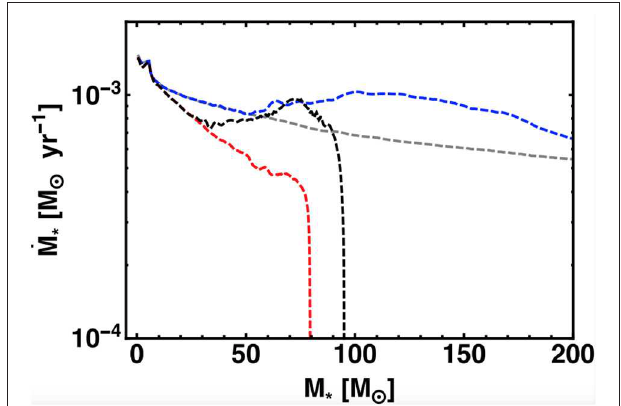
FIGURE 12 | The role of radiation and protostellar jet feedback in the formation of massive stars. Gray line is for outflow feedback only; blue line, outflow + photoionization feedback; red line, ouflow + radiation forces; black line, outflow + radiation forces + photoionization. From Kuiper and Hosokawa (2018) reproduced with permission c (cid:13)